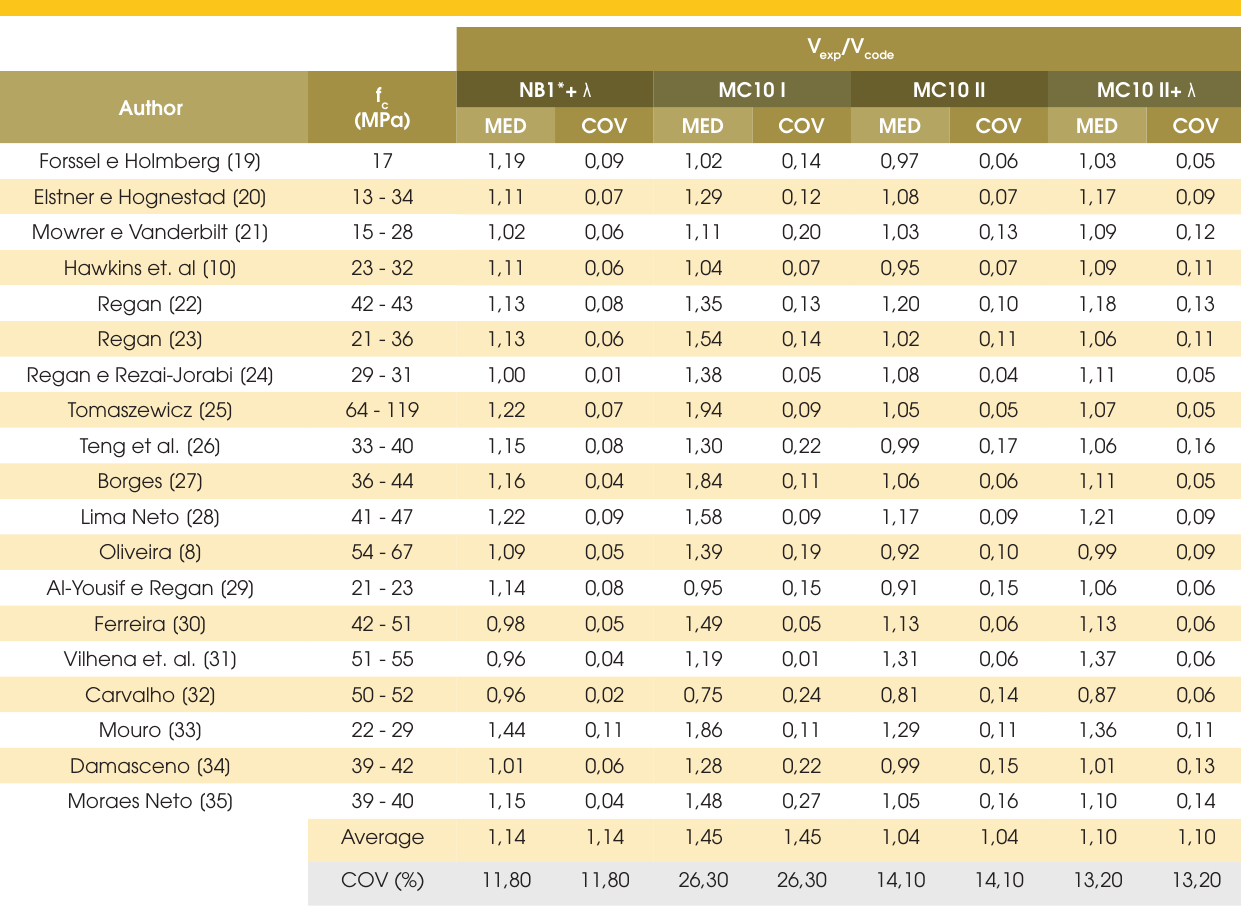
Table 3b – Comparison between the experimental and theoretical results